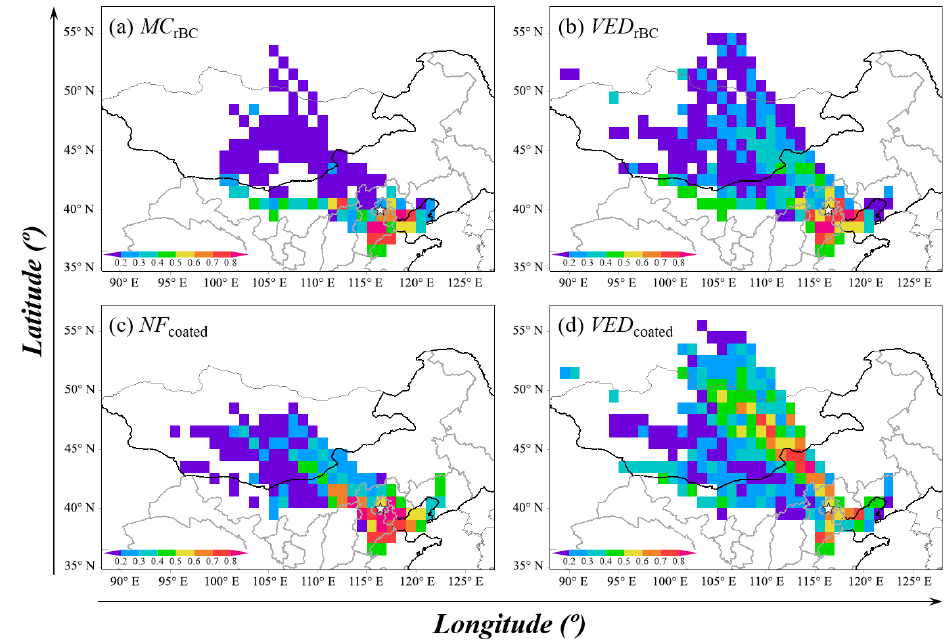
Figure 3. Distributions of gridded (1 ◦ × 1 ◦ ) potential source contribution functions of (a) mass concentration (MC) and (b) volume- equivalent diameter (VED) of rBC as well as (c) number fraction (NF) and (d) VED of thickly coated rBC. The overlaid star symbol represents the geographical location of the observation